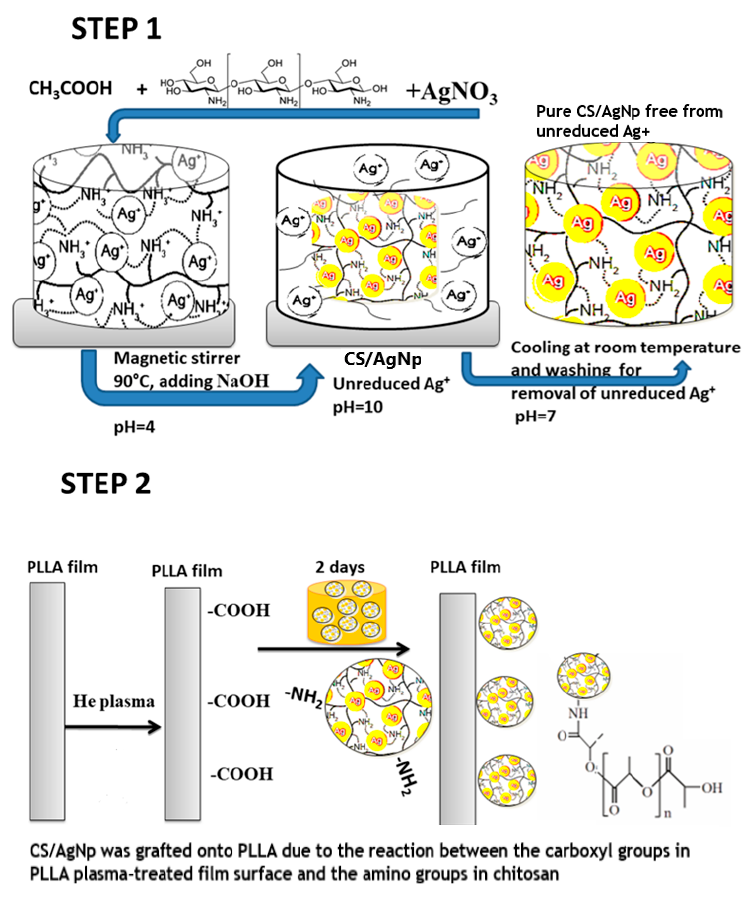
Figure 1. Scheme of two steps experimental method.